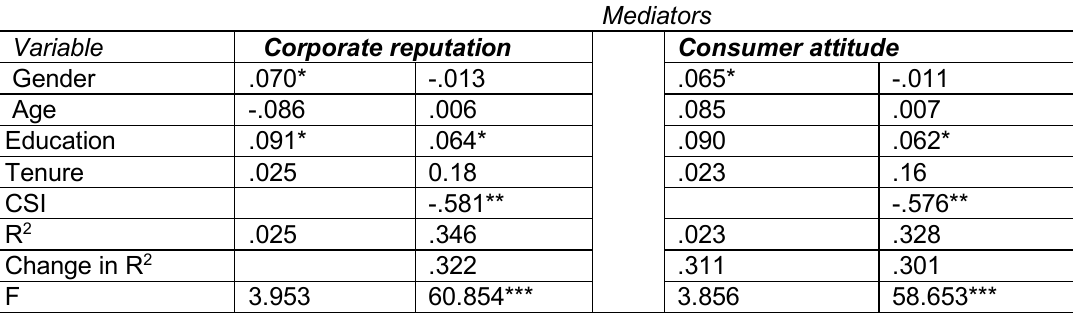
Table 4: Hierarchical Regressions Predicting the impact of CSI on CR and